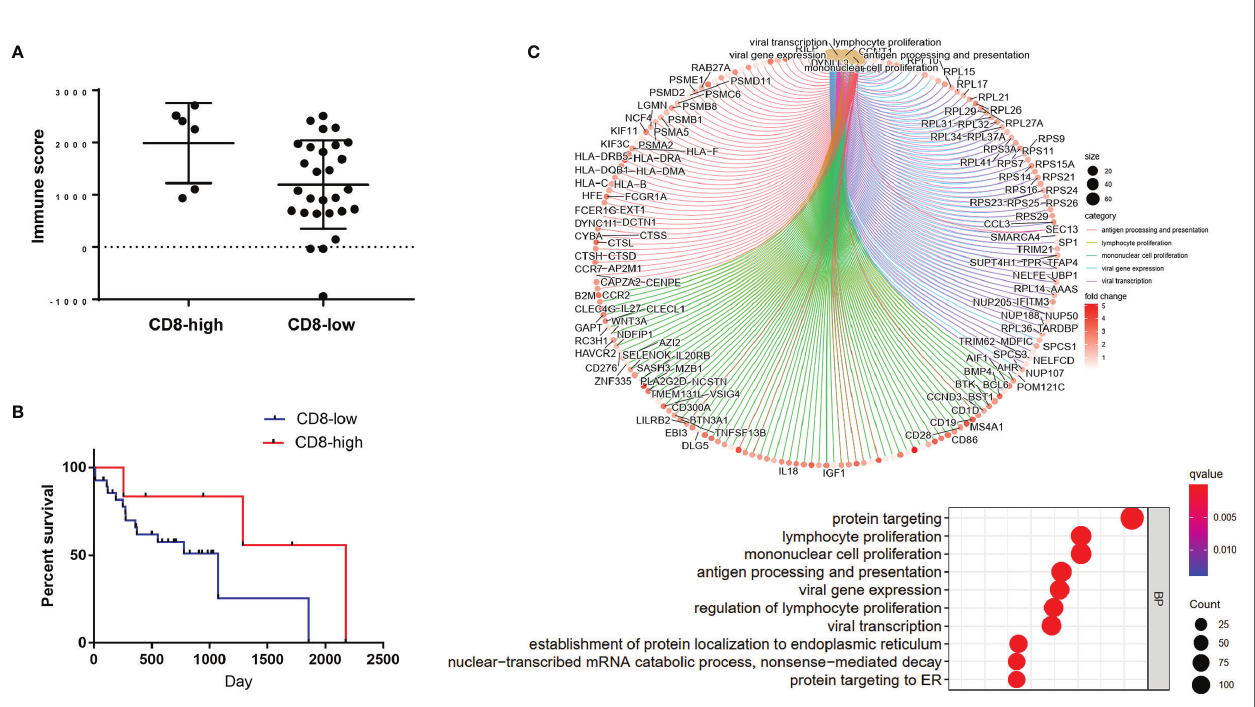
FIGURE 6 | Application of the radiomics-clinical combined model in TCIA cohort. (A) Immune scores of the predicted CD8-high and CD8-low groups. (B) The overall survival curve of these two predicted groups. (C) The enrichment relationship between genes and the main enriched terms (up) and the top 10 BP terms (bottom) in GO